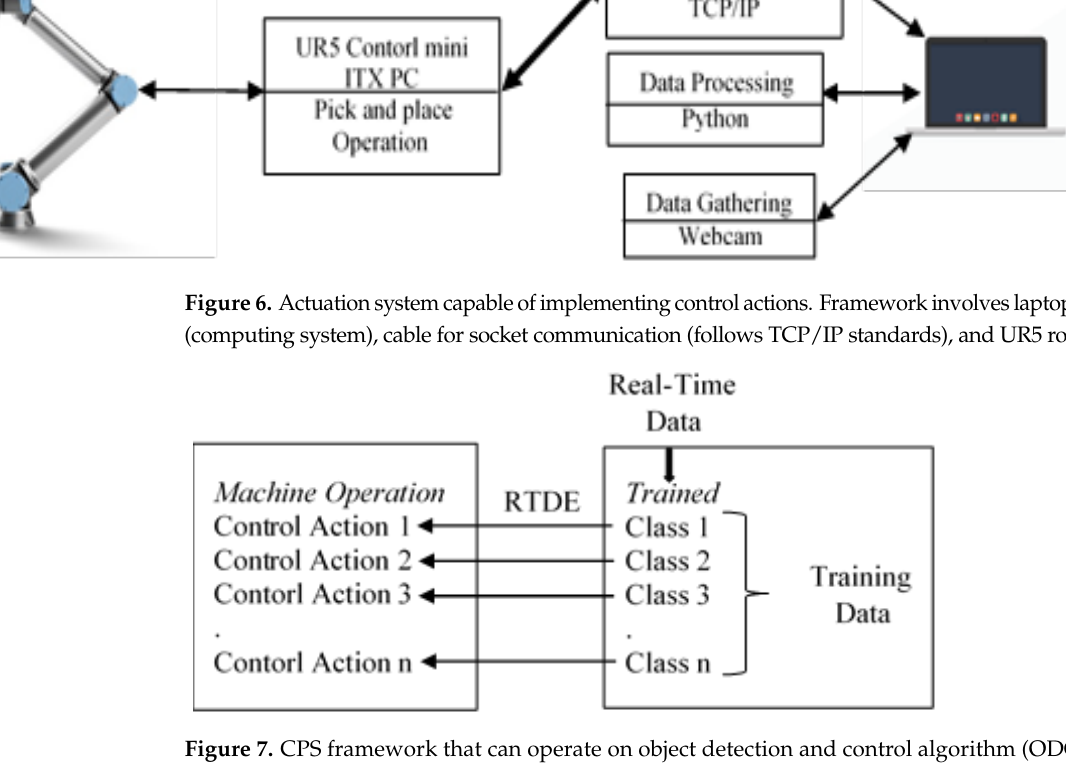
Figure 7. CPS framework that can operate on object detection and control algorithm (ODCA).